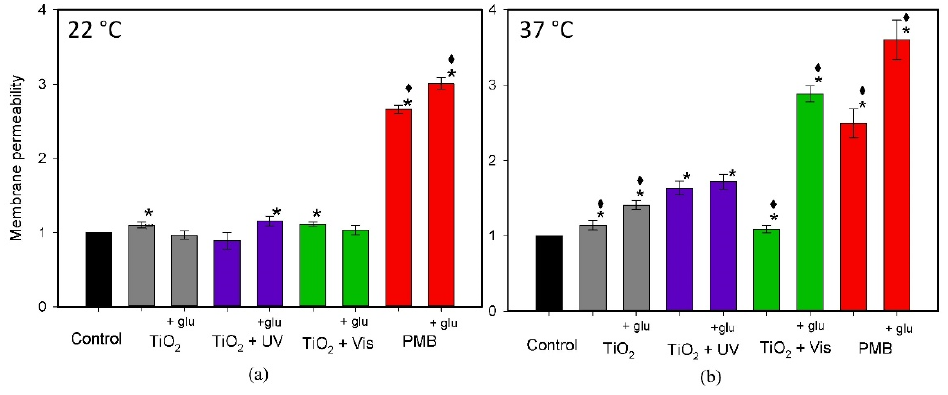
Figure 4. Influence of the incubation temperature and the irradiation source on the outer membrane permeabilizing activity of TiO 2 : ( a ) 22 °C and ( b ) 37 °C. The experiments were performed in PBS buffer, pH 7.4, with/without 0.1% glucose. Concentration of S. Typhimurium cells was 3 × 10 7 cfu/mL, and concentration of TiO 2 was 0.3 mg/L. * and ♦ mark experimental values which are significantly different from the control sample and other samples respectively (more details on statistical analysis are provided in Section 4.5).